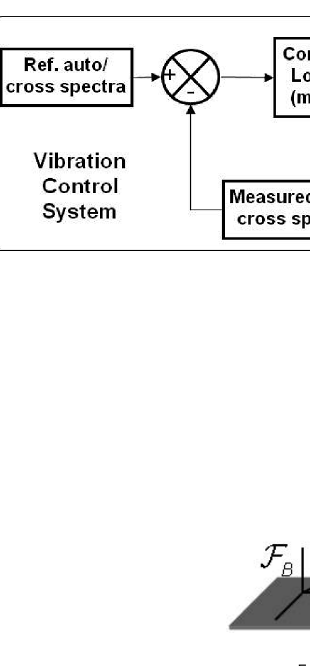
Fig. 4. Accelerometer Placement